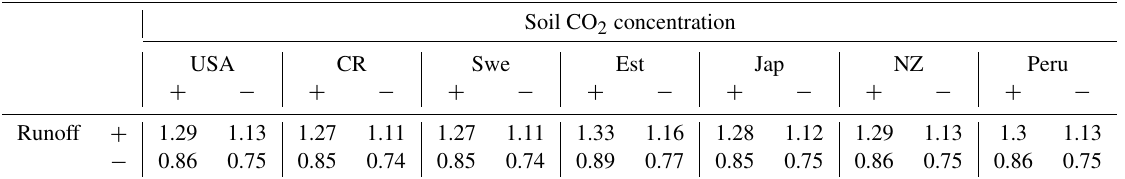
Table 6. Sensitivity of eco-hydrological-controlled weathering regime at respective locations with ( + ) 20% enhancement and ( − ) 20% decrease of runoff and soil CO 2 concentration relative to the original enhancement due to vegetation from Table 5.